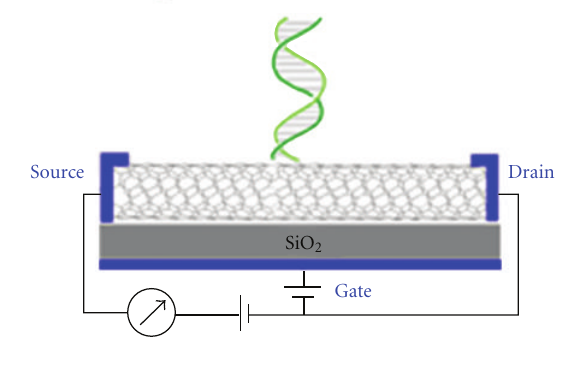
Figure 5: Diagram of DNA